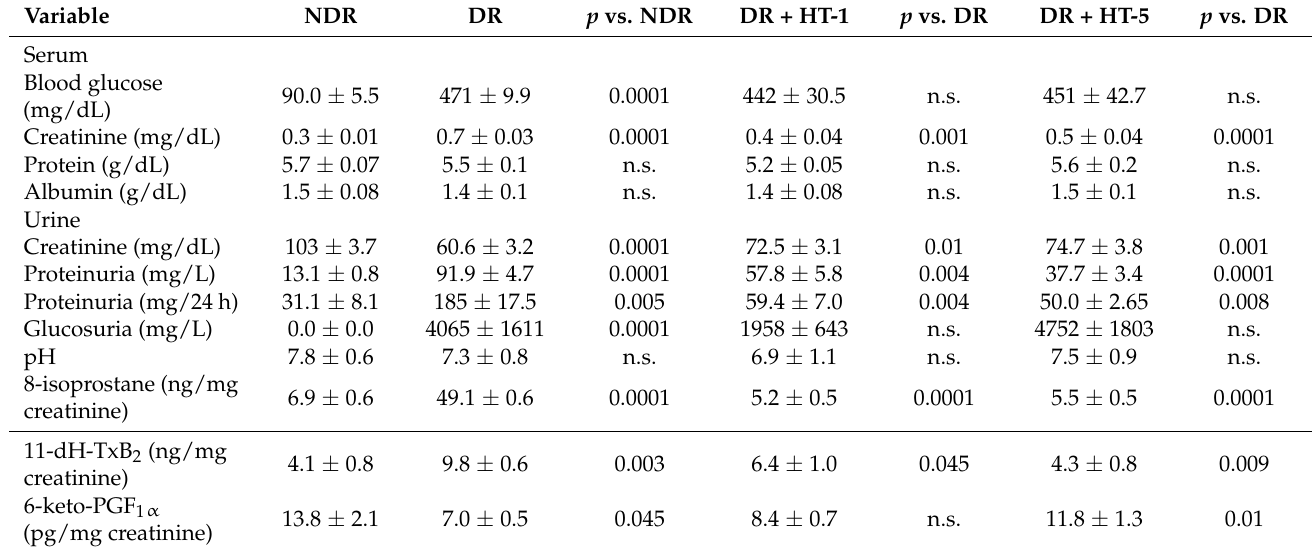
Table 1. Serum and urine variables (mean ± standard error of the mean) of nondiabetic rats (NDR), diabetic control rats (DR), and DR treated with hydroxytyrosol (HT) 1 mg/kg/day p.o. (HT-1) or 5 mg/kg/day p.o. (HT-5). N = 10 rats per